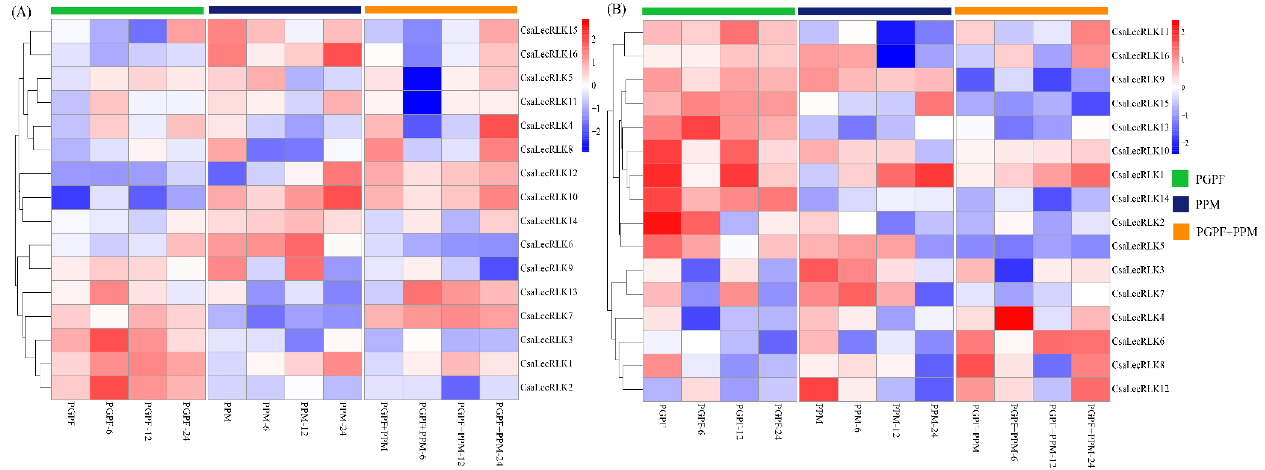
Figure 8. qRT-PCR validation of ( A ) L-type LecRLK and ( B ) G-type LecRLK genes in cucumber in response to T. harzianum (PGPF), Golovinomyces orontii (PPM), and a combination of the two (PGPF+PPM) treatments, respectively. The heatmap was generated based on the Log2 value using the Rstudio program (A package of R, USA).